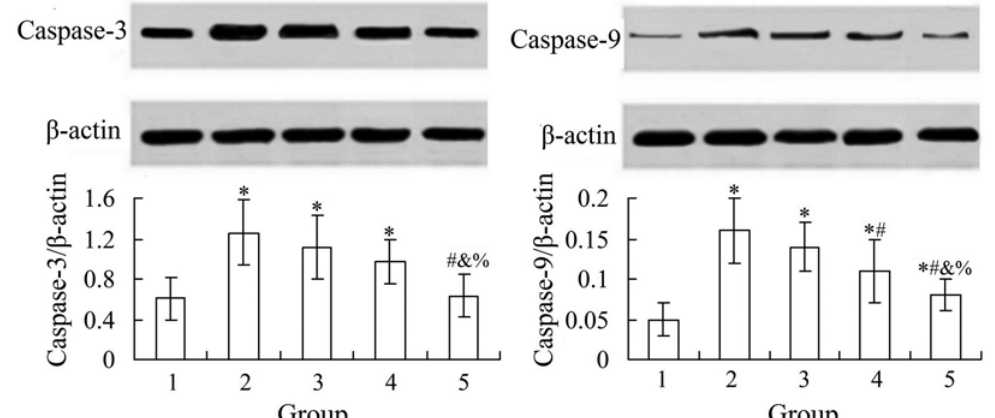
FIGURE 1 - Effects of salidroside on myocardial Caspase-3 and Caspase-9 protein expressions in rats. * P < 0.05 compared with sham-operated group; # P < 0.05 compared with model group; & P < 0.05 compared with low-dose salidroside group; % P < 0.05 compared with middle-dose salidroside group. 1: Sham-operated group; 2: Model group; 3: low-dose salidroside group; 4: middle- dose salidroside group; 5: high-dose salidroside group. Caspase-3, cysteinyl aspartate-specific proteinase-3; Caspase-9, cysteinyl aspartate-specific